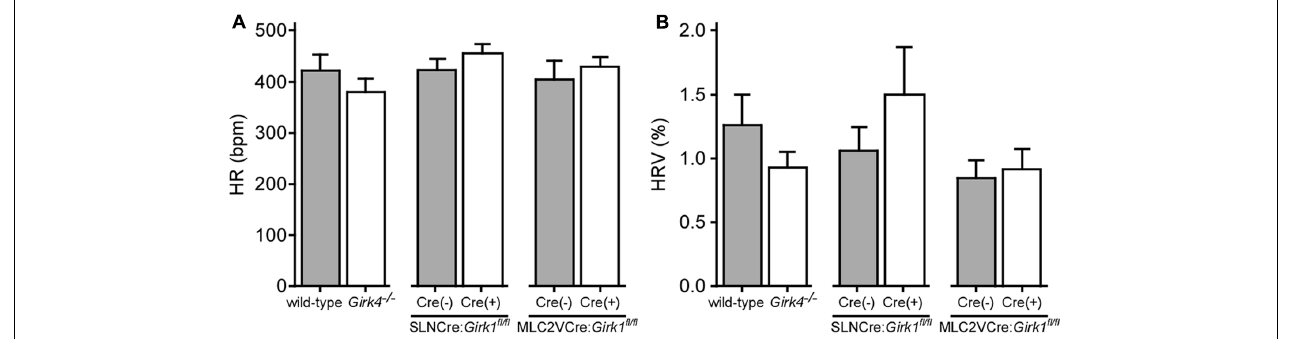
FIGURE 3 | Impact of whole-heart and tissue-specific GIRK channel ablation on baseline HR and HRV. (A) Summary of baseline HR data. There were no significant differences in baseline HR between wild-type ( n = 10) and Girk4 − / − ( n = 10) mice ( t 18 = 1.0; P = 0.32), SLNCre(–): Girk1 fl / fl ( n = 6) and SLNCre(+): Girk1 fl / fl ( n = 5) mice ( t 9 = 1.1; P = 0.29), or MLC2VCre(–): Girk1 fl / fl ( n = 6) and MLC2VCre(+): Girk1 fl / fl ( n = 8) mice ( t 12 = 0.7; P = 0.51). (B) Summary of baseline HRV data. There were no significant differences in HRV between wild-type ( n = 10) and Girk4 − / − ( n = 10) mice ( t 18 = 1.2; P = 0.23), SLNCre(–): Girk1 fl / fl ( n = 5) and SLNCre(+): Girk1 fl / fl ( n = 5) mice ( t 8 = 1.1, P = 0.32), or MLC2VCre(–): Girk1 fl / fl ( n = 6) and MLC2VCre(+): Girk1 fl / fl ( n = 8) mice ( t 12 = 0.32; P = 0.76).